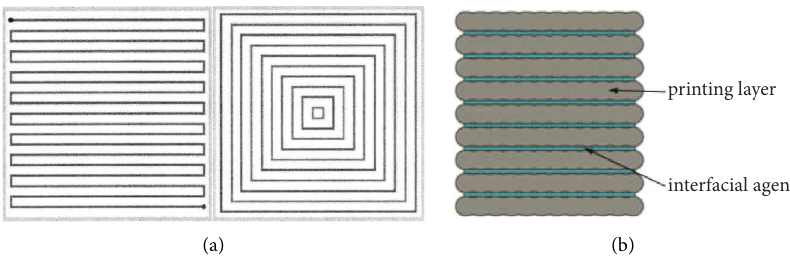
Figure 28: Parallel scan path and contour scan path (a) [52] and printing layer and interfacial agent distribution (b) [50].